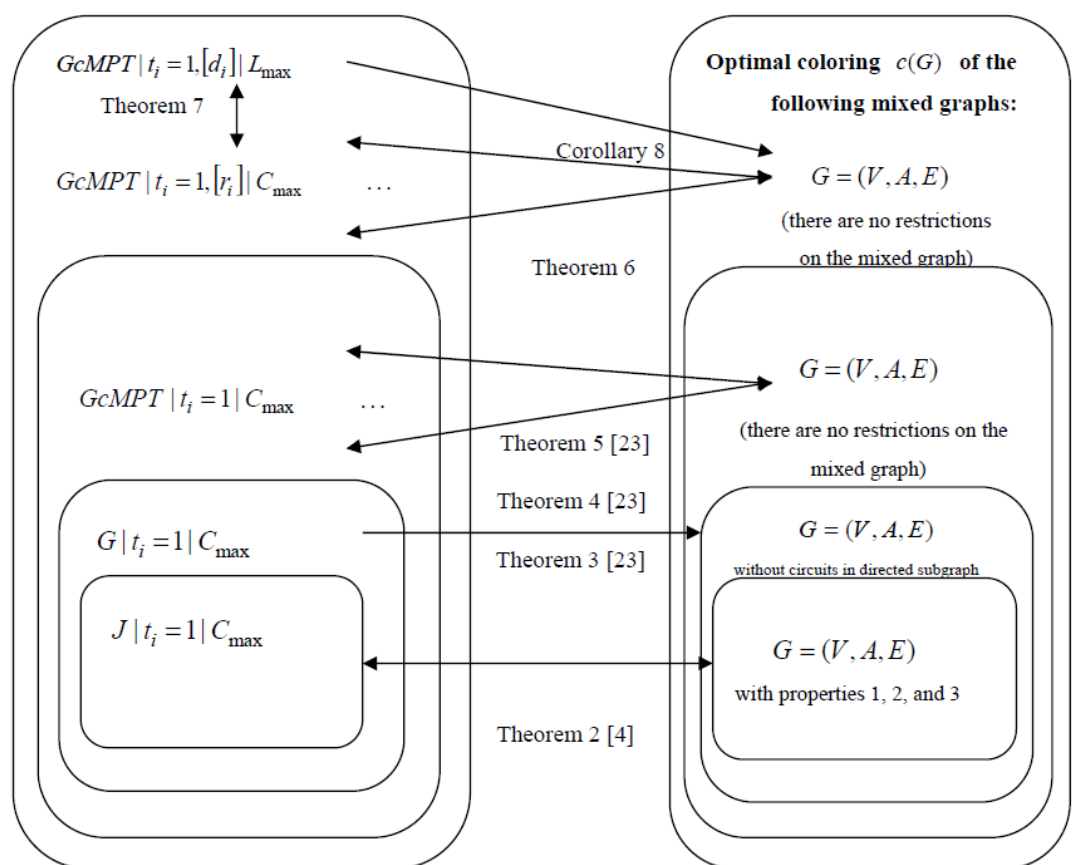
Figure 5. Optimal colorings c ( G ) of the mixed graph G = ( V , A , E ) and equivalent scheduling problems α | t i = 1 | γ on the mixed graph G = ( V , A , E ) , where α ∈ { J , G , GcMPT } and γ ∈ { C max , L max } [4,23].